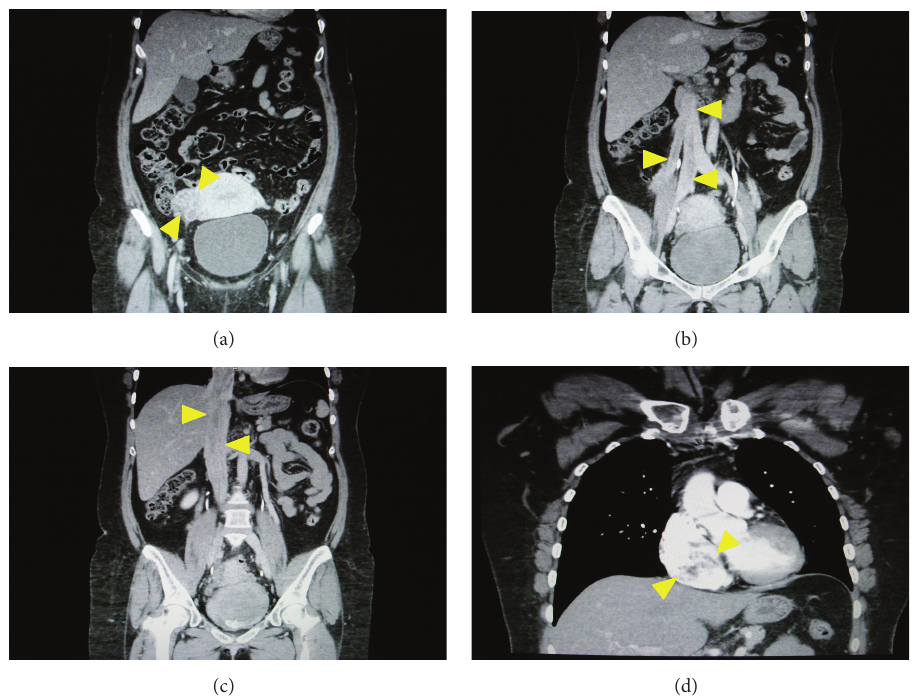
Figure 1: Computed tomogram of the chest, abdomen, and pelvis showed a large mass within the inferior vena cava, extending into the right atrium and ventricle. (a) Coronal image demonstrates large filling defect in the right parametrium. (b, c) Coronal image presents large filling defect in the inferior vena cava extending from both the right uterine vein and common iliac and the right ovarian vein to the inferior vena cava and the right atrium. (d) Coronal image demonstrates large filling defect in the right